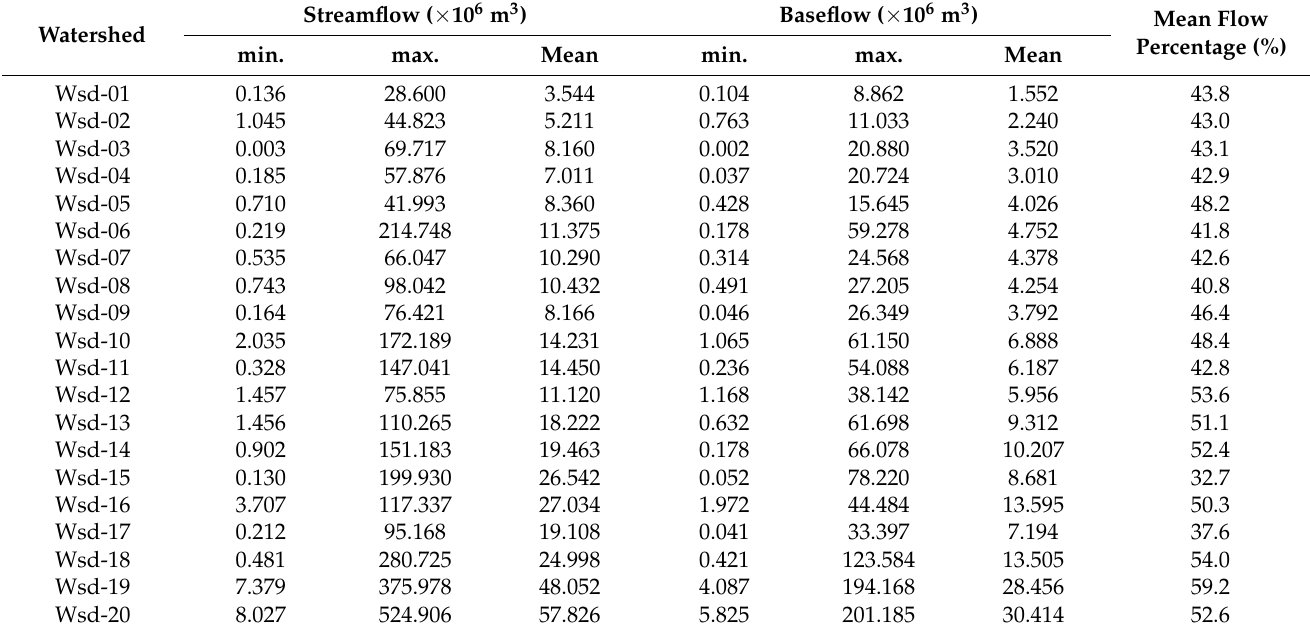
Table 3. Statistics describing the streamflow and separated